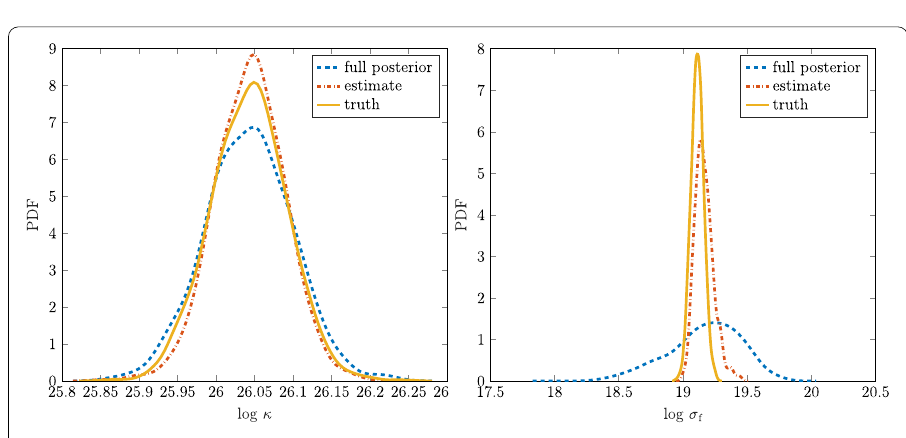
Fig. 13 Estimated posterior of the log of macro-scale parameters w.r.t. to their true value. “Full posterior” represents both aleatoric plus epistemic uncertainty, whereas “estimate” is only the aleatoric